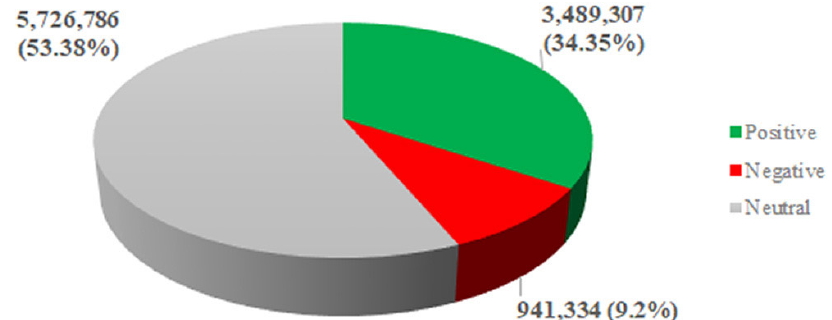
Fig. 2. Polarity frequency of the tweets over the years 2010–2020 using TextBlob